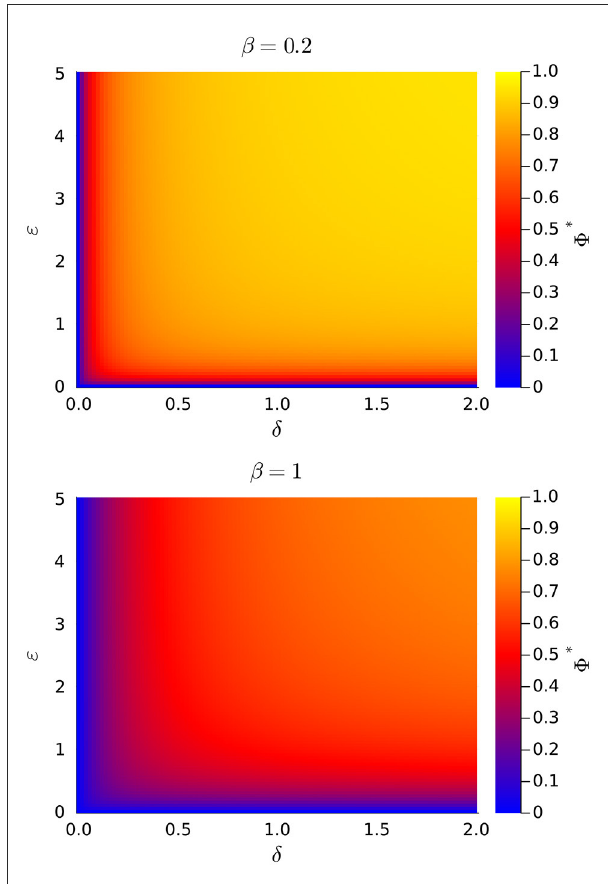
FIGURE4 Plots of the fraction of stationary functional mitochondrial volume f ∗ m ∗ ) vs. the rates of mitochondrial fission ( δ ) and density ( 8 ∗ = + mitophagy ( ǫ ), for a couple of values of the damaging rate ( β ). All rate are normalized to the intrinsic mitogenesis